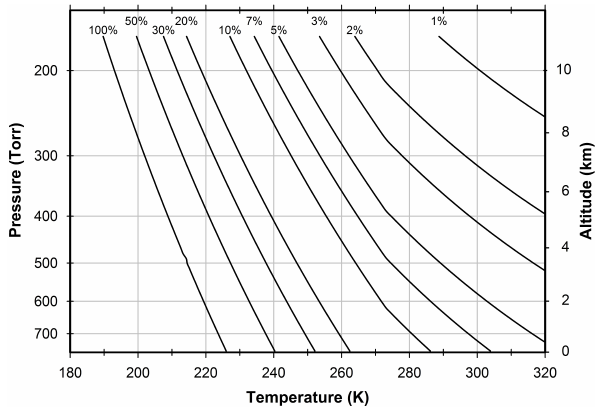
Fig. 6. Dependence of α CH on the H 2 and CH 4 mixing ratios in 3 O 2 the calibration cell air mixture at three inlet [NO]/[O 2 ] conditions. Error bars show the standard error of each α CH 3 O 2